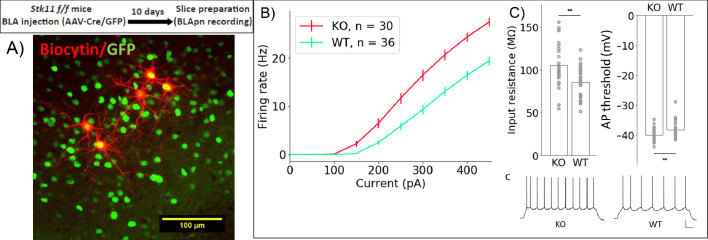
Stk11 deletion in BLApn increases intrinsic excitability.(A) Whole-cell recordings obtained from BLApn in ex vivo slices of Stk11f/f mice 10 days after injection of Cre or control virus. Stk11 neurons were targeted based on GFP expression and validated post-hoc based on Biocytin fills. (B) Firing rates plotted against input current (F–I). Error bars are SEM. Less current is needed to evoke firing in Stk11-KO neurons compared to Stk11-WT neurons (interpolated rheobase, F(1,64) = 10.6, p=0.0018). Two-way mixed ANOVA revealed significant main effects of knockout (F(1,64) = 27.48, p=2×10−6) and current (F(10,640) = 581.7, p=1.2×10−44) on firing rate, along with a statistically significant interaction (F(10,640) = 22.4, p=4×10−36). Post-hoc pairwise comparisons showed that the firing rates of Stk11-KO neurons were significantly greater than those of Stk11-WT neurons in response to current injections from 150 to 450 pA (p<0.001). (C) Stk11-KO neurons have increased input resistance (F = 14.41, p=3.3×10−4) and decreased threshold for generating action potential (F = 7.68, p=0.0073). Traces are sample responses to 300 pA current steps. Scale bar: 100 ms, 20 mV. See also Table 4.